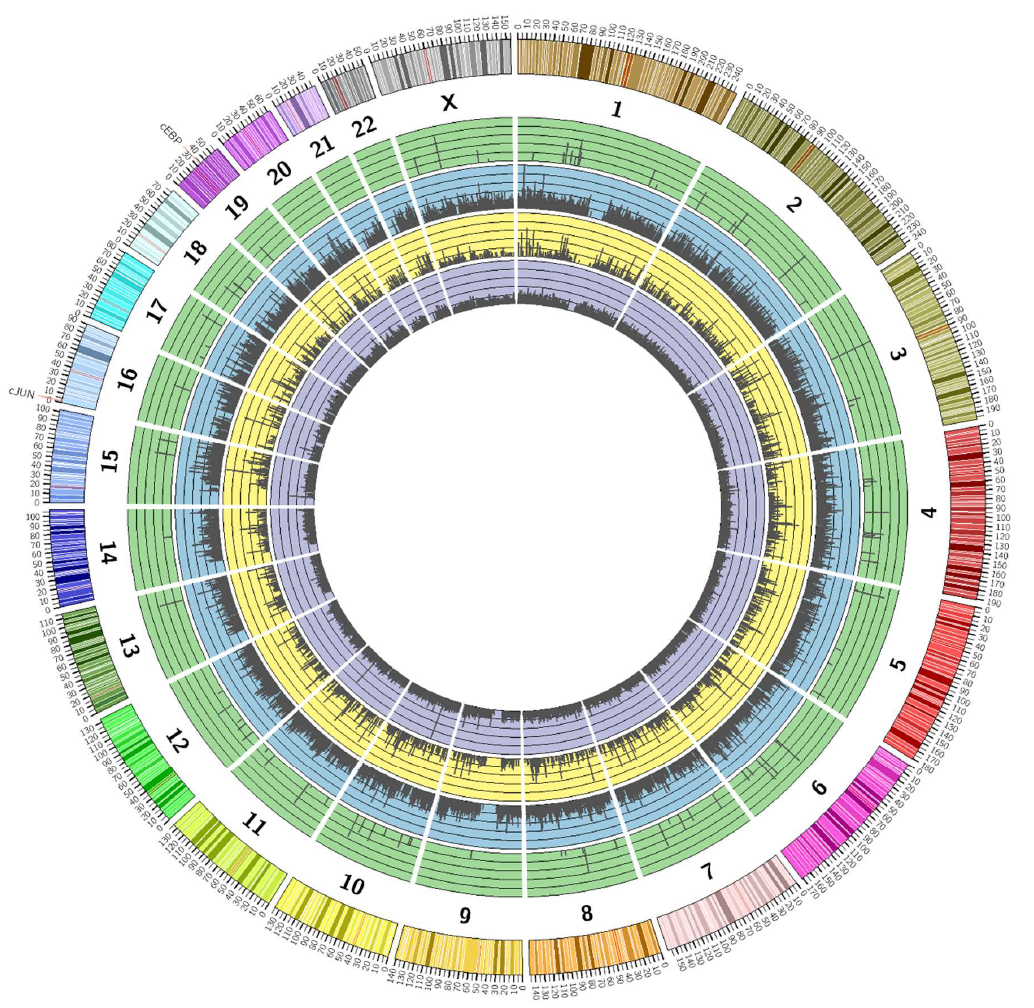
Figure 3. Custom scripts were created to compare the list of known genes closest to ChIP peaks (see Supplementary Materials). These corroborated gene lists were visualised on a chromosome map using Circos plots (circos.ca). Genes that demonstrate c-Jun binding following stimulation are indicated by peaks in the purple (for I942) and yellow (for F / R) coloured bands, whereas genes that demonstrate C / EBP β binding sites following stimulation are in the blue (for F / R) and green (for I942) coloured bands. Chromosome number is indicated by numerals in bold and chromosome positions are indicated in the outside ring.